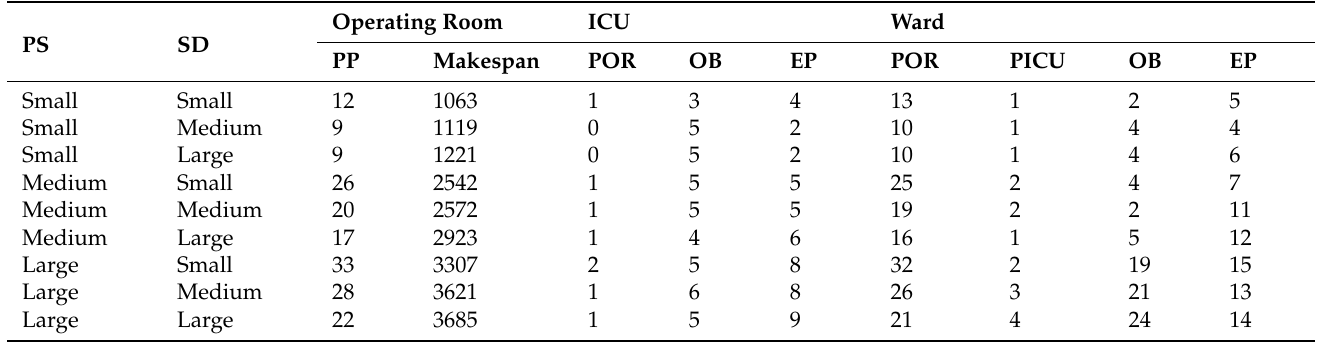
Table 6. Summary results of the lower-level plan when the ICU becomes the bottleneck.